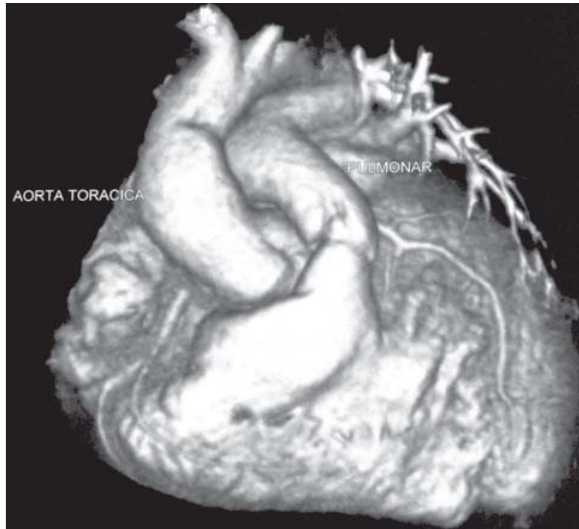
1. Rastelli GC, Wallace RB, Ongley PA. Complete repair of transposition of the great arteries with pulmonary stenosis. A review and report of a case corrected by using a new surgical technique. Circulation. 1969;39(1):83-95.